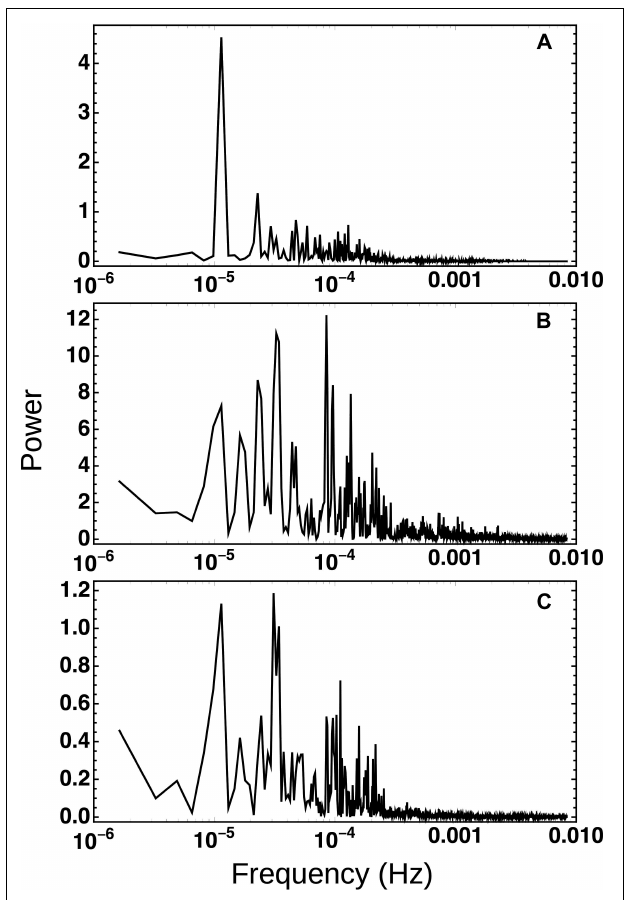
FIGURE 3 | Spectral analysis of de-trended temperature gradient and wind speed signals. Signals were de-trended using a moving average filter (see the main text for details). The figure shows the periodograms computed for signal (A) and wind speed signals recorded at the Eolo (B) , or at the Serpente (C) entrances.